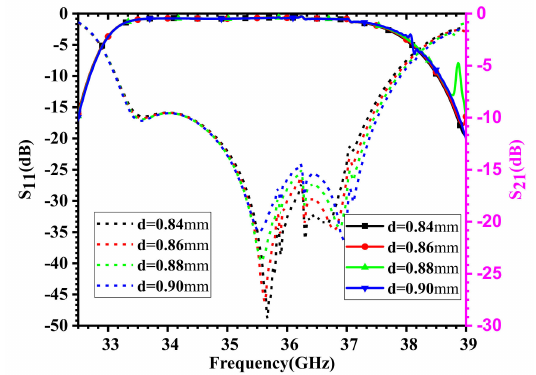
Figure 4. The influence of the coupling rectangle gap width on transmission and reflection of the input